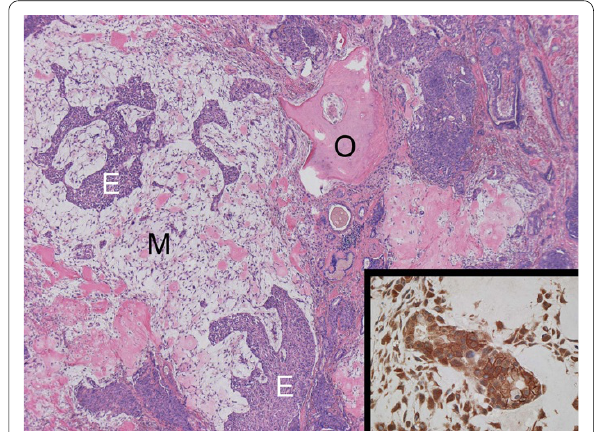
Figure 4 Histological feature of mixed tumor of soft tissue with a variety of components; epithelial component E, myoepithelial component M, and osseous metaplasia O (H-E stain, ×40) . Tumor cells overexpressing anti-Na + /K + -ATPase antibody (small window in right lower corner, immunohistochemical staining,